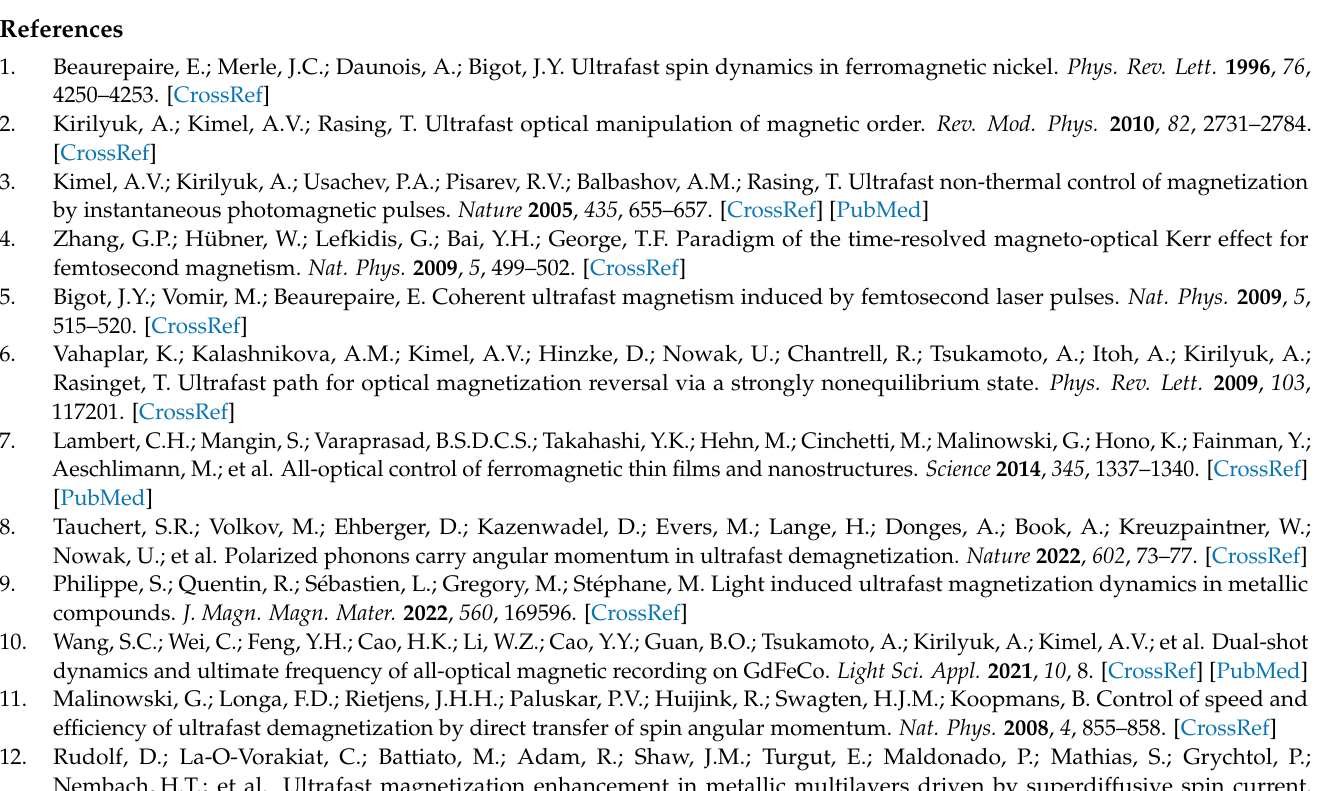
Figure S2: The fittings of charge currents with j c ( t ) and j res ( t ) contributions at difference pump fluence range from 0.4 mJ/cm 2 to 1.2 mJ/cm 2